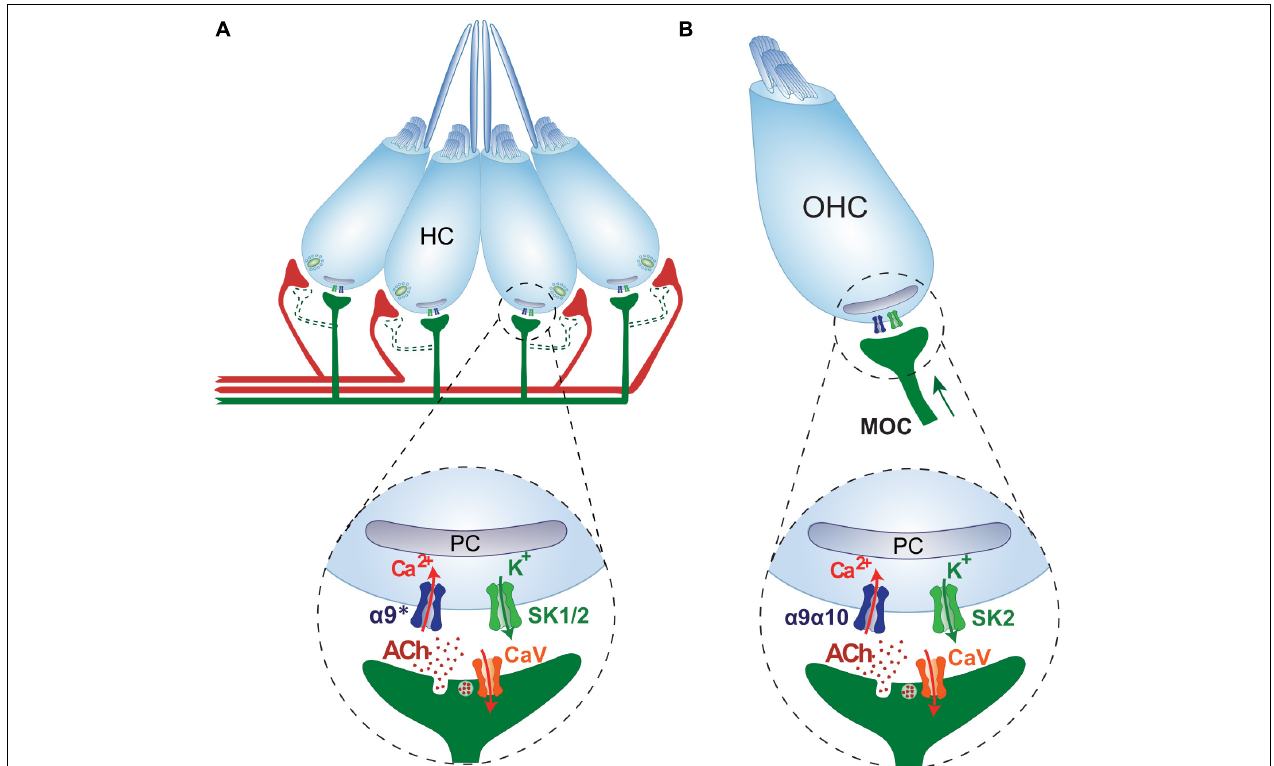
FIGURE 4 | Cholinergic lateral line and cochlear efferent synapses share structural, functional and molecular similarities. (A) Schematics of the cholinergic LL efferent synapse. LL HCs are innervated by afferent (red) and cholinergic efferent (green) fibers. Evidence for efferent cholinergic fibers contacting afferent neurons (dashed light green) is still missing. The net effect of LL efferent cholinergic activity is to hyperpolarize HCs. This is mediated by the activation of an α 9* nAChR with high Ca 2 + permeability. Subsequent activation of Ca 2 + -dependent K + SK channels drives HC hyperpolarization (Carpaneto Freixas et al., 2021). Postsynaptic cisterns (PC) opposed to efferent terminals are co-extensive with the efferent synaptic contact (Dow et al., 2018). (B) Schematics of the cholinergic MOC-OHC efferent synapse. OHCs are innervated by MOC cholinergic efferent (green) fibers. The net effect of MOC activity is to hyperpolarize OHCs. This is mediated by the activation of an α 9 α 10 nAChR with high Ca 2 + permeability (Elgoyhen et al., 2001; Lustig et al., 2001; Sgard et al., 2002; Gómez-Casati et al., 2005; Elgoyhen and Katz, 2012). Subsequent activation of Ca 2 + -dependent K + SK2 channels drives OHC hyperpolarization (Dulon et al., 1998). Postsynaptic cisterns (PC) opposed to MOC terminals have been proposed to participate in Ca 2 + compartmentalization and/or Ca 2 + -induced Ca 2 + release